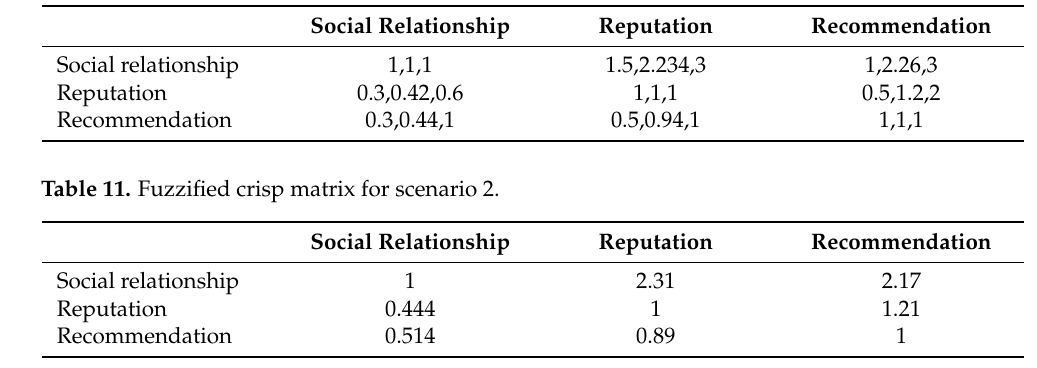
Table 10. FPCM for scenario 2.